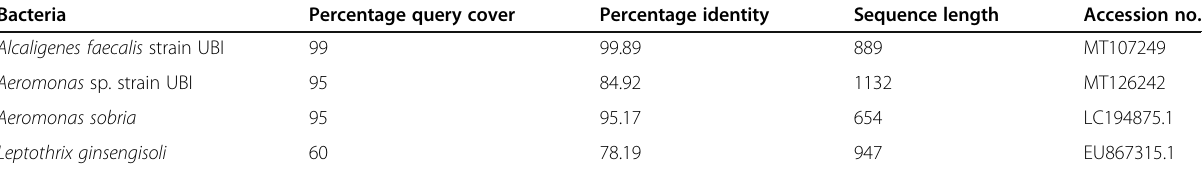
Table 7 Hit similarity of sequences of the isolates from GenBank of NCBI Bacteria